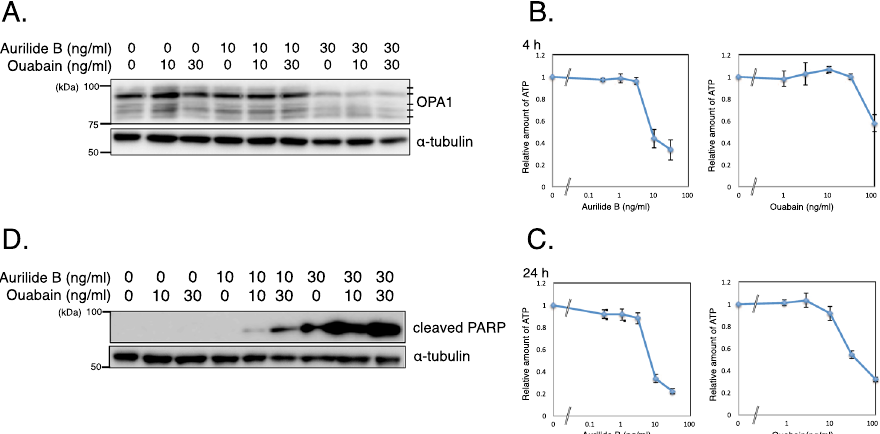
Figure 5. Combined treatment of aurilide B with ouabain. ( A ) Cells were treated for 24 h with the indicated concentrations of aurilide B or ouabain. OPA1 was analyzed by Western blotting. α -tubulin served as a loading control. ( B , C ) Cells were treated for 4 h ( B ) or 24 h ( C ) with the indicated concentrations of aurilide B or ouabain. Cellular ATP content was measured by ATPlite. For the 24-h samples, data were normalized against protein content. Data represent means ± SD from three independent experiments. ( D ) Cells were treated for 24 h with the indicated concentrations of aurilide B or ouabain. Cleaved PARP was analyzed by Western blotting. Uncropped blots are found in Supplementary Fig.